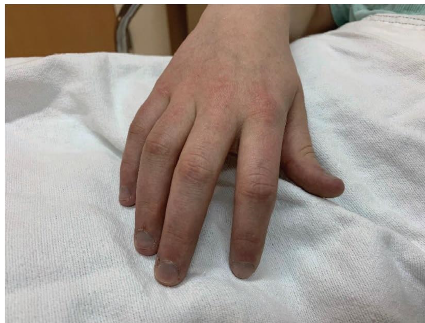
Figure 2: Cyanosis from congenital methemoglobinemia may also result in discoloration of the extremities and nails.